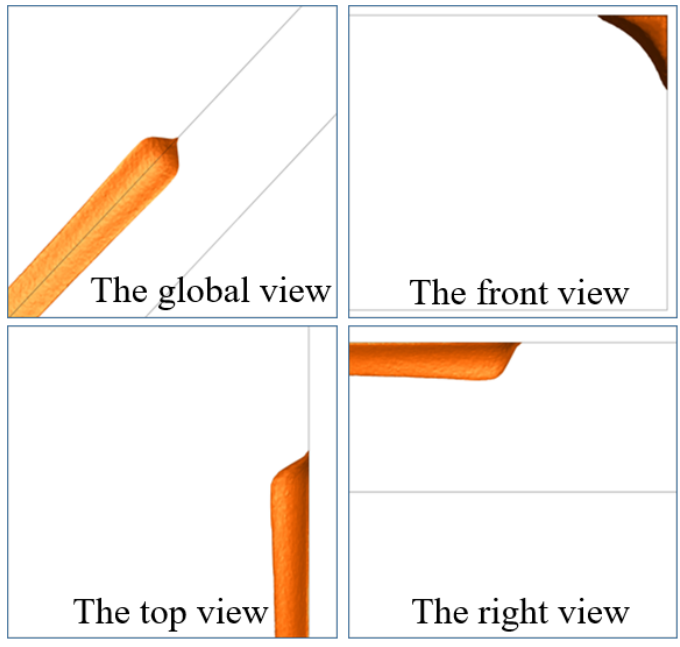
Figure 16. ISO-surface of 1797 K temperature at 20